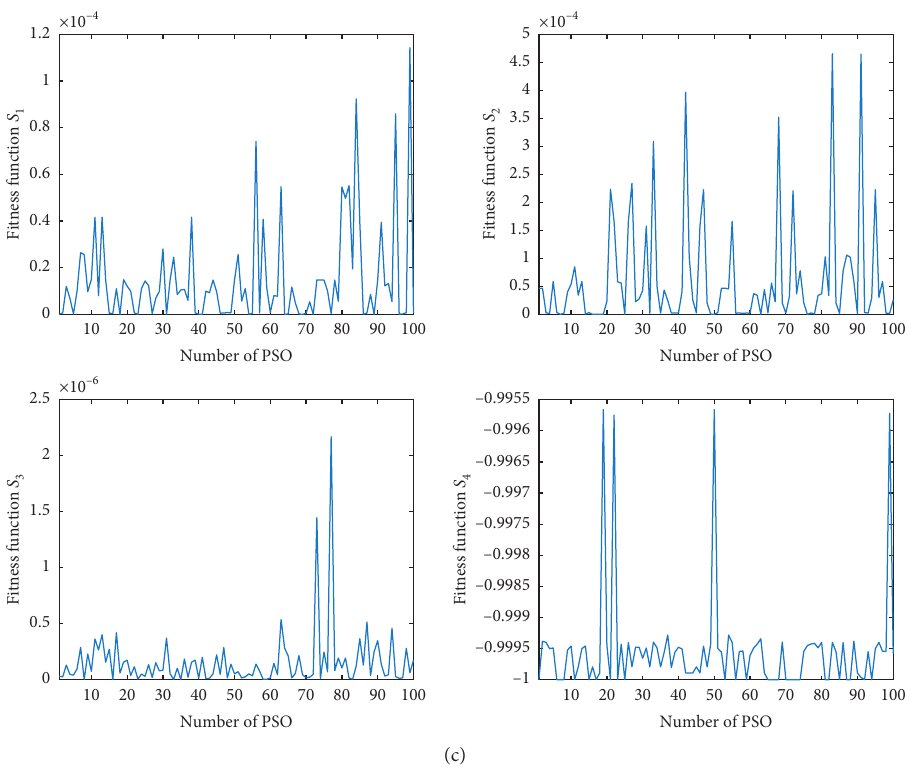
Figure 5: Variation of the fitness functions S